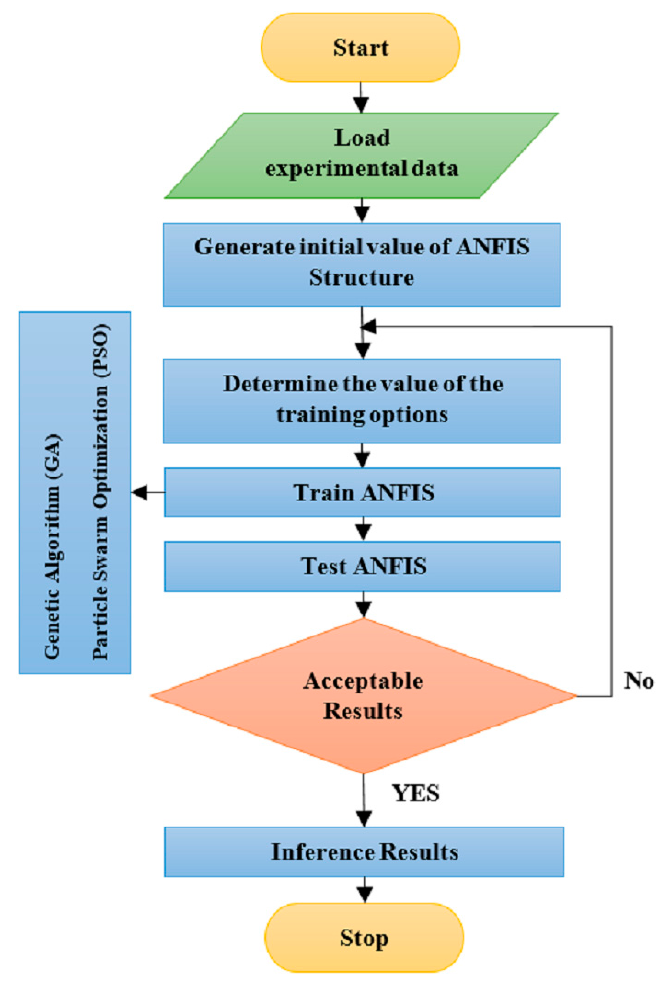
Figure 2. The process of ANFIS training.